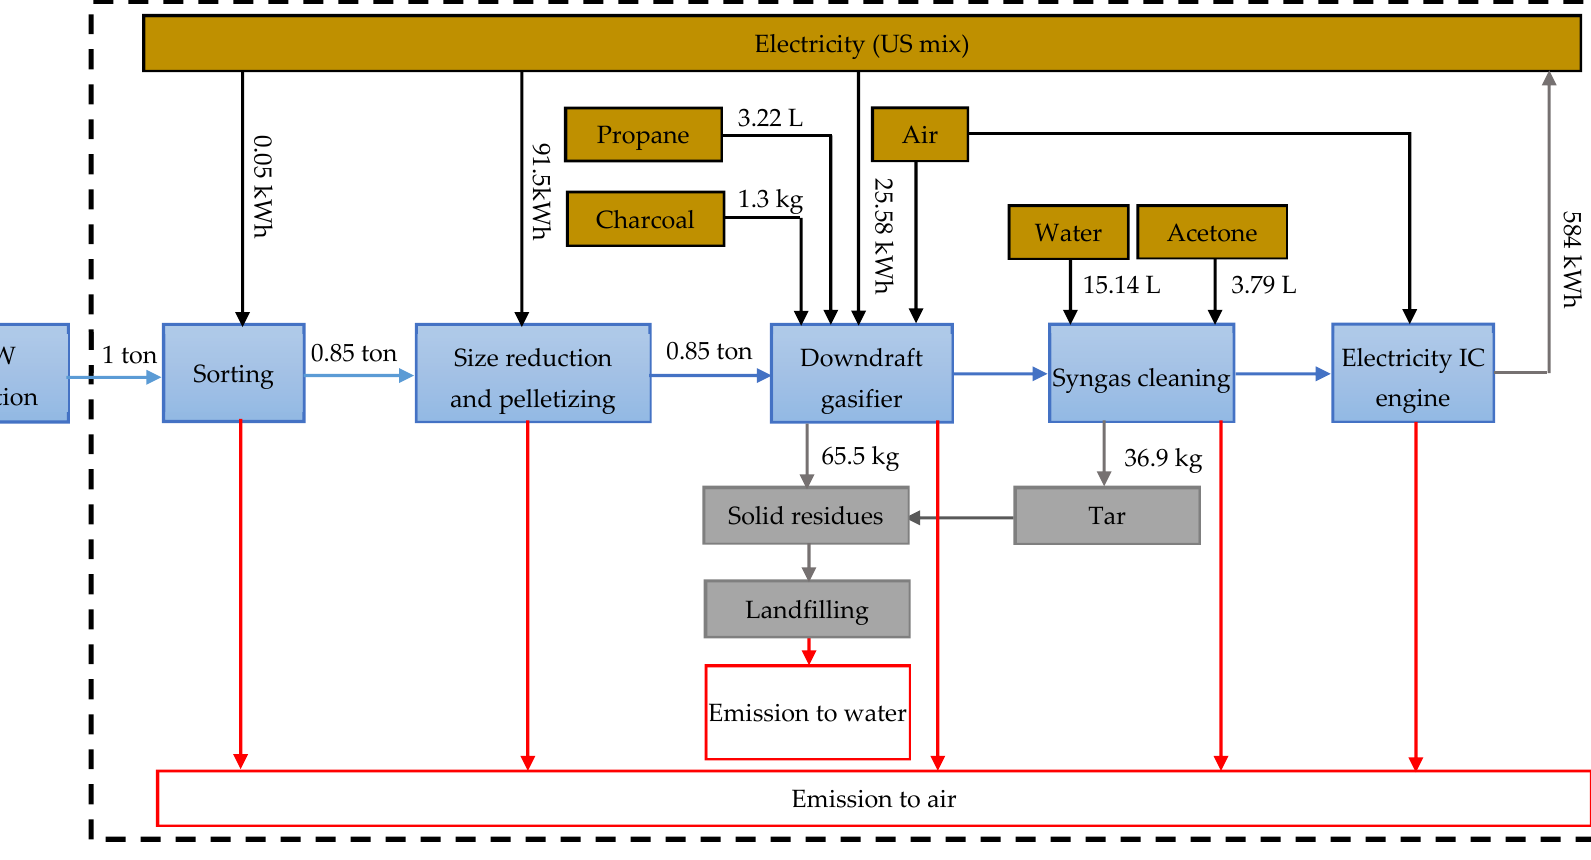
Figure 3. MSW gasification process flow diagram.